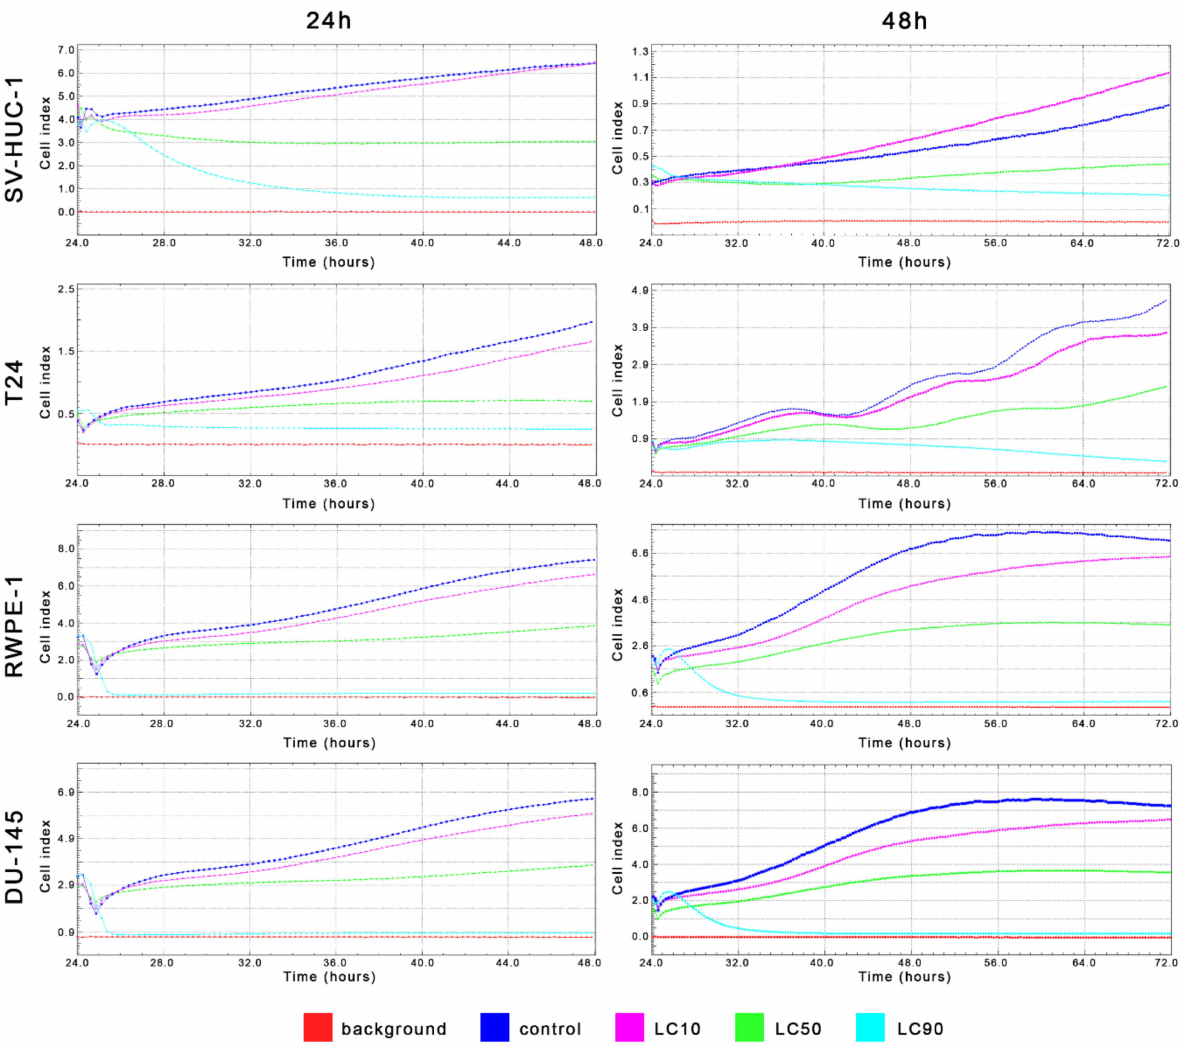
Figure 11. Real-time cell growth analysis of bladder and prostate cell lines after levofloxacin treatment. Data were measured every 30 min for 24 or 48 h. The obtained results confirmed that the LC values calculated using MTT assay actually cause a reduction of cells viability by 10, 50, and 90%. SV-HUC-1—non-malignant human urothelium; T24—human bladder cancer; DU-145—human prostate cancer; RWPE-1—non-malignant human prostate